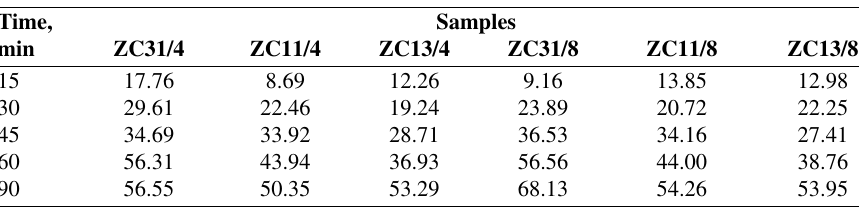
Table 5 . Degradation of Malachite Green with the time, % Time,